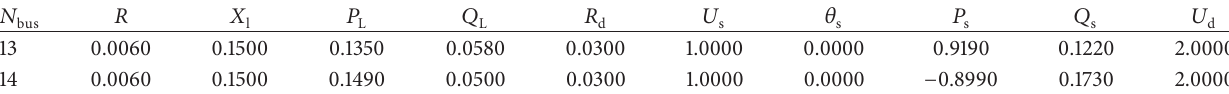
Table 2: Initial DC variable parameters (p.u.) of VSC-HVDC